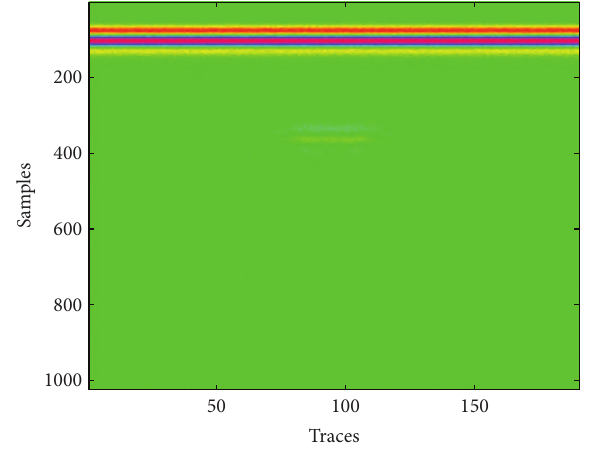
Figure 11: Raw radargram of copper.